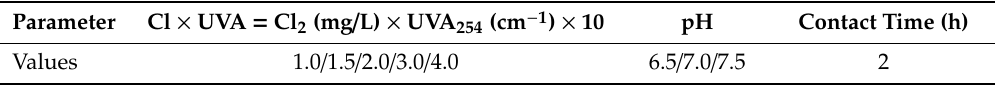
Table 2. Experimental parameters for filtered water (FW)